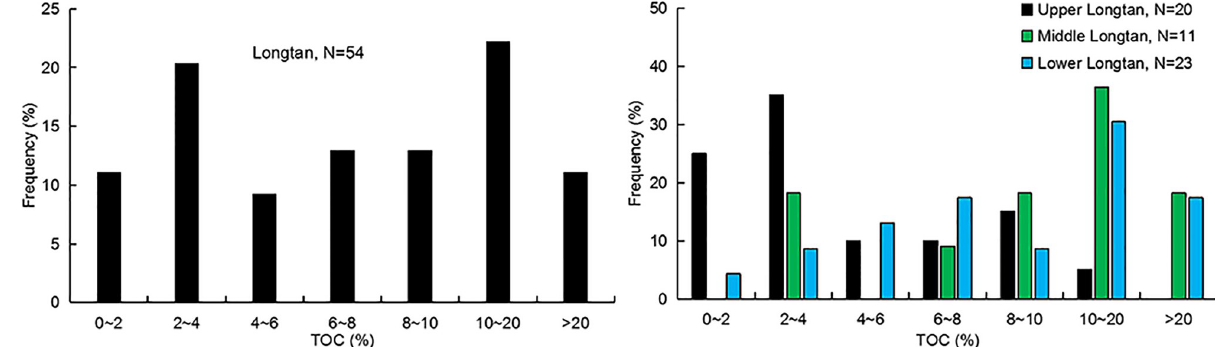
Fig 5. Distribution of TOC contents of the Longtan Formation samples: (A) Distribution of all TOC contents; (B) Distribution of TOC in different sections of the Lower, Middle, and Upper Longtan members (data from this study and [13, 15, 30]).